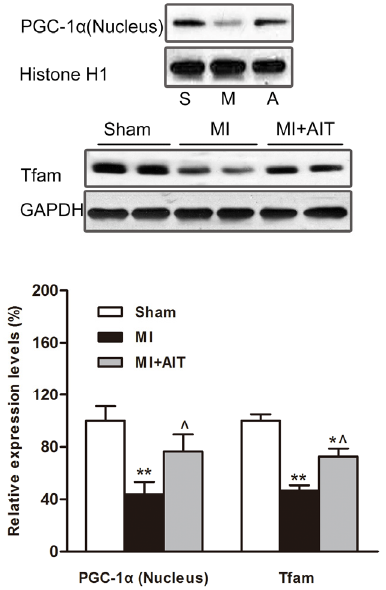
Figure 7. Effects of MI and AIT on PGC-1 α and Tfam. After eight weeks, the rats were killed, and the expression levels of nuclear PGC-1 α and Tfam were determined by Western blot (Top: Western blot images; bottom: statistical results). Significant differences were calculated using one-way ANOVA followed by Tukey’s post-hoc test. The data are presented as the means ± SEM ( n = 8). * p < 0.05 and ** p < 0.01 vs. sham group, ^ p < 0.05 vs. MI group. Sham (S): sham operation; MI (M): myocardial infarction; MI + AIT (A): myocardial infarcted rats subjected to aerobic interval